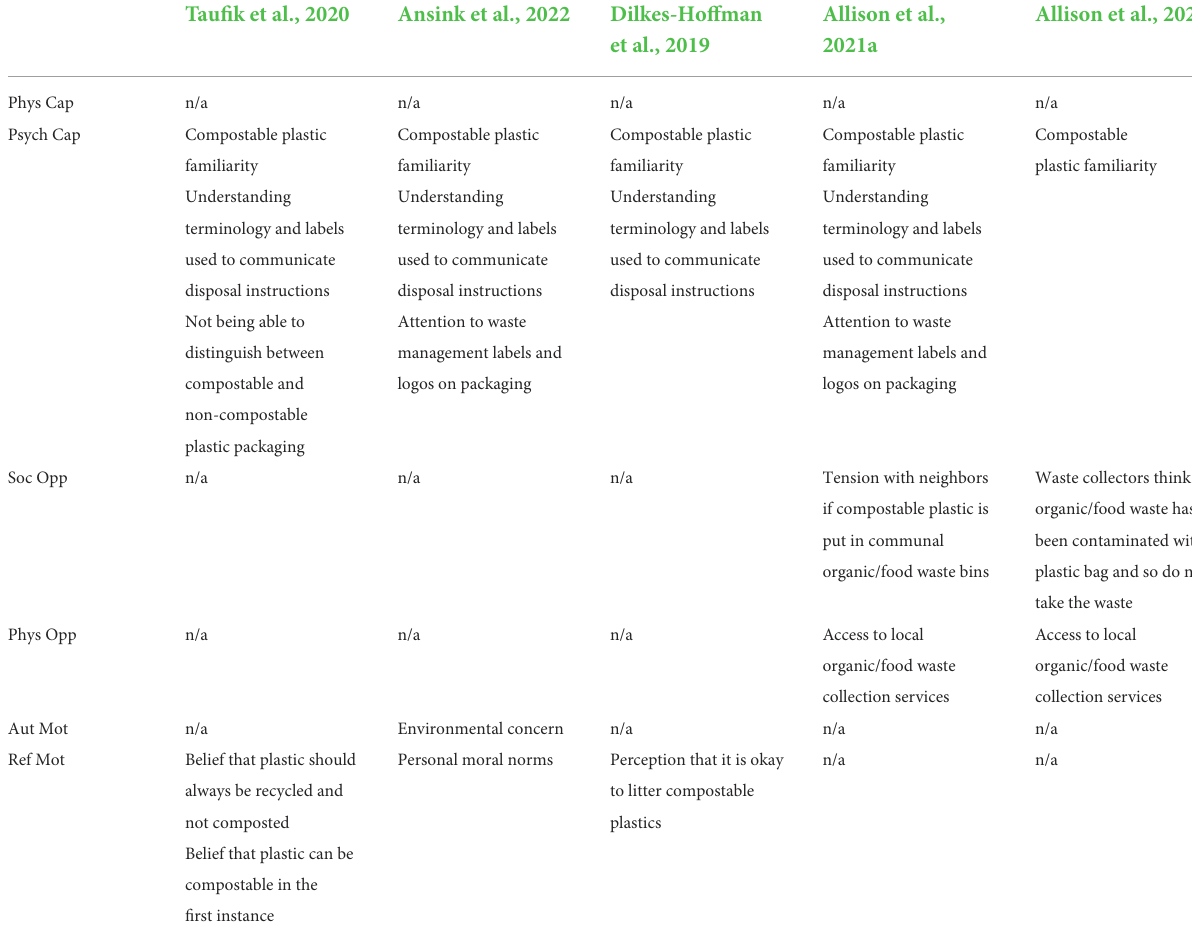
TABLE 1 Table showing factors associated with compostable plastic waste